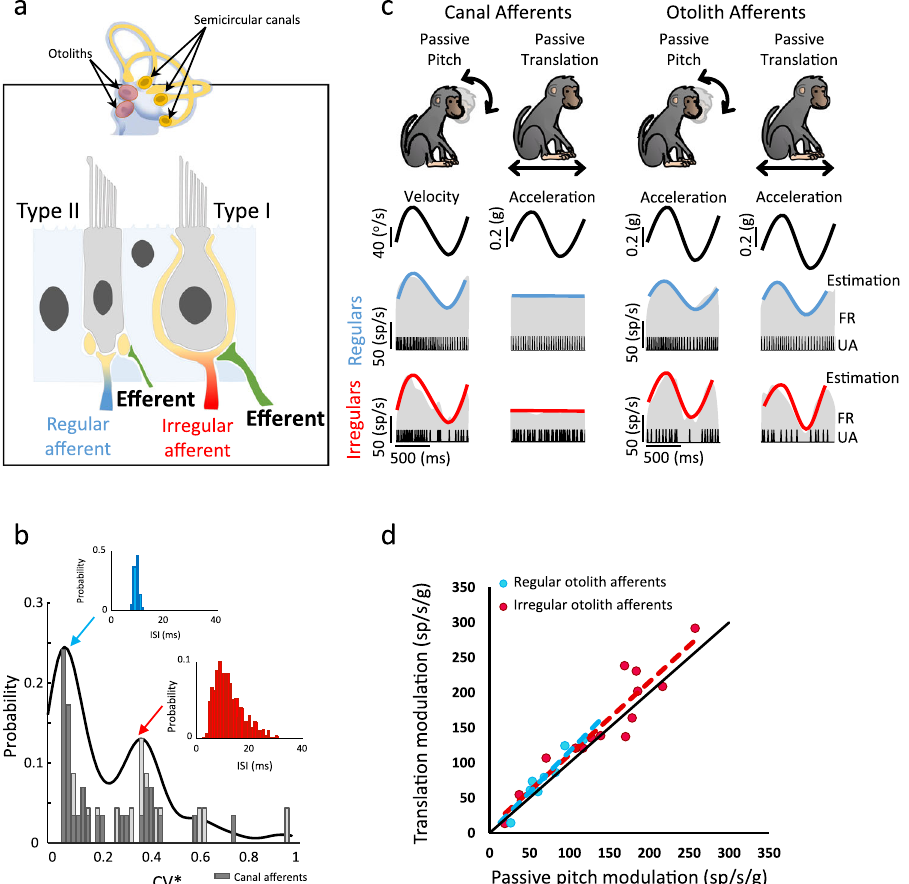
Fig. 1 Characterization of vestibular afferents. a The vestibular labyrinth comprises fi ve sensory organs: the three semicircular canals and the two otoliths. Within the sensory epithelia of each sensory organ (indicated by arrows) are the receptor cells, which in mammals comprise two types of hair cells: cylindrical type II and fl ask-shaped type I hair cells. Both canal and otolith afferent fi bers are classi fi ed on the basis of the regularity of their resting discharge, and in general, irregular afferents (red) preferentially transmit information from the type I hair cells, whereas regular afferents (blue) preferentially transmit information from type II hair cells. The vestibular efferent system (green) consists of a group of neurons located in the brainstem neighboring the abducens nucleus, which projects back out to the vestibular periphery. b Bimodal distribution of the normalized CV (CV*) for all recorded afferents (Hartigan ’ s dip test , p = 0.04, p = 0.02). Inset shows interspike interval distribution for an example regular (blue) and an example irregular (red) vestibular afferent. c Characterization protocol for vestibular afferents. Semicircular canals afferents encode head velocity during head pitch but not during body translation whereas otoliths afferents encode linear head acceleration during both protocols. d Otolith afferents have similar sensitivity to passive translation and passive pitch (regression slope: regular otolith afferents: p = 2.1 × 10 − 4 , CI = 0.42 VAF: translation = 0.92 ± 0.03,